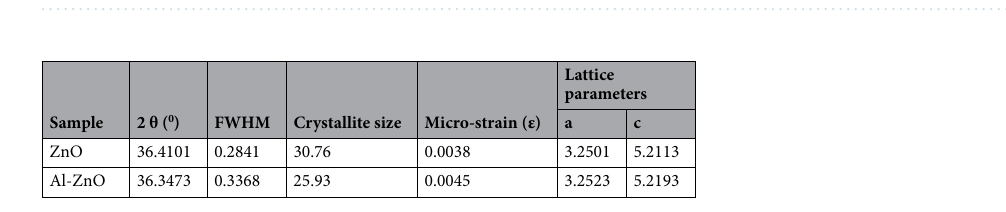
Table 1. Structural parameter derived from XRD data